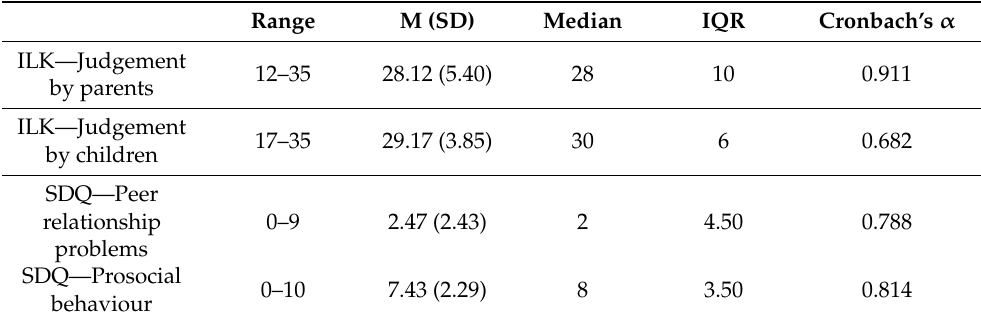
Table 3. Descriptive statistics and internal consistency of the measurements in the present